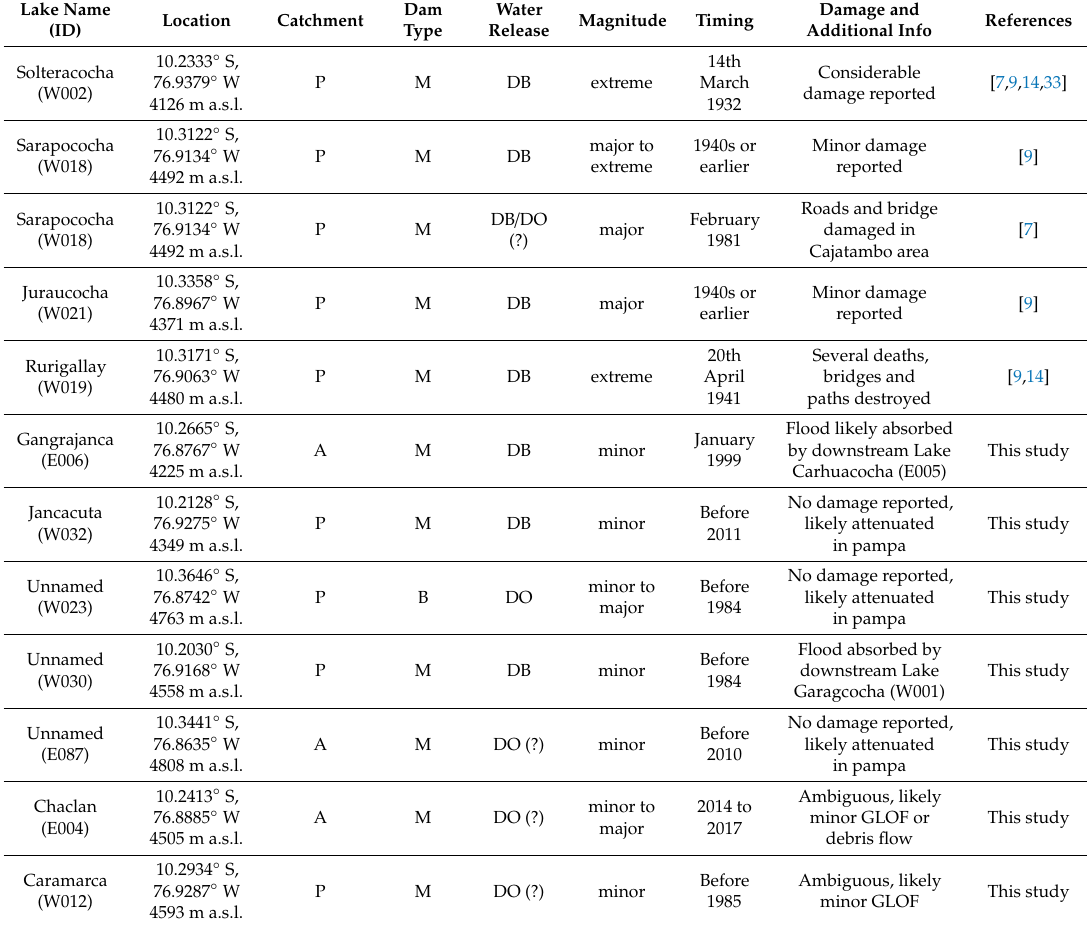
Table 4. Overview of past GLOFs in the Cordillera